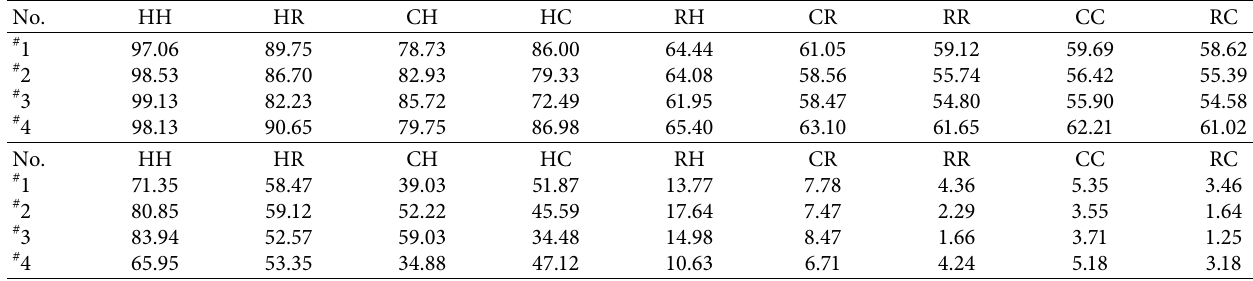
Table 9: Mean percentage qualities of the best-found schedules returned by the LS algorithms (the top table) and mean percentage improvements of the lengths of schedules returned by the LS phase with respect to the lengths of schedules returned by the initialization phase (the bottom table) for each of the four classes of the benchmark given in [7, 8] with cov � 90%. No. HH